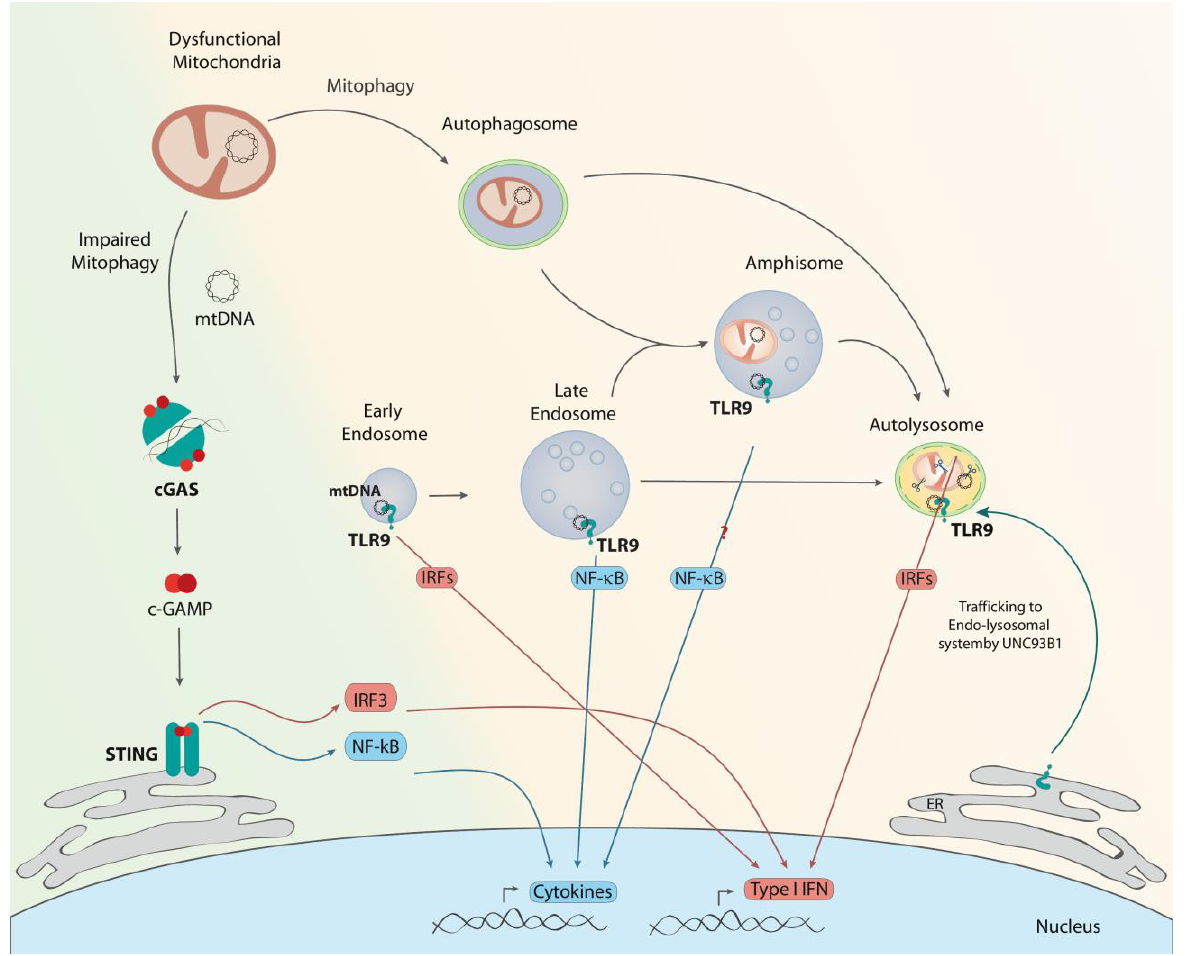
FIGURE 2: cGAS and TLR9 activation by mtDNA. Under conditions of impaired mitophagy initiation (green background), thus accumulation of dysfunctional mitochondria, there is mtDNA leakage to the cytosol. cGAS homodimers recognize double stranded DNA as mtDNA and produce c-GAMP, which interacts with STING, triggering IRF3 or NF- κ B, and in turn the expression of type I IFNs or cytokines, respectively. Under conditions in which mitophagosomal formation occurs normally but resolution is defective (orange background), mtDNA instability can lead to its recognition by TLR9 in different endosomal compartments. TLR9 is recruited from the ER to the endo-lysosomal system, guided by UNC93B1. Engagement of TLR9 in early endosomes or lysosomes results in type I IFN expression through various IRFs. Interac- tion of mtDNA with TLR9 in late endosomes results in NF- κ B activation. Given the resemblance of amphisomes to late endosomes, TLR9 engagement in amphisomes could result in cytokine